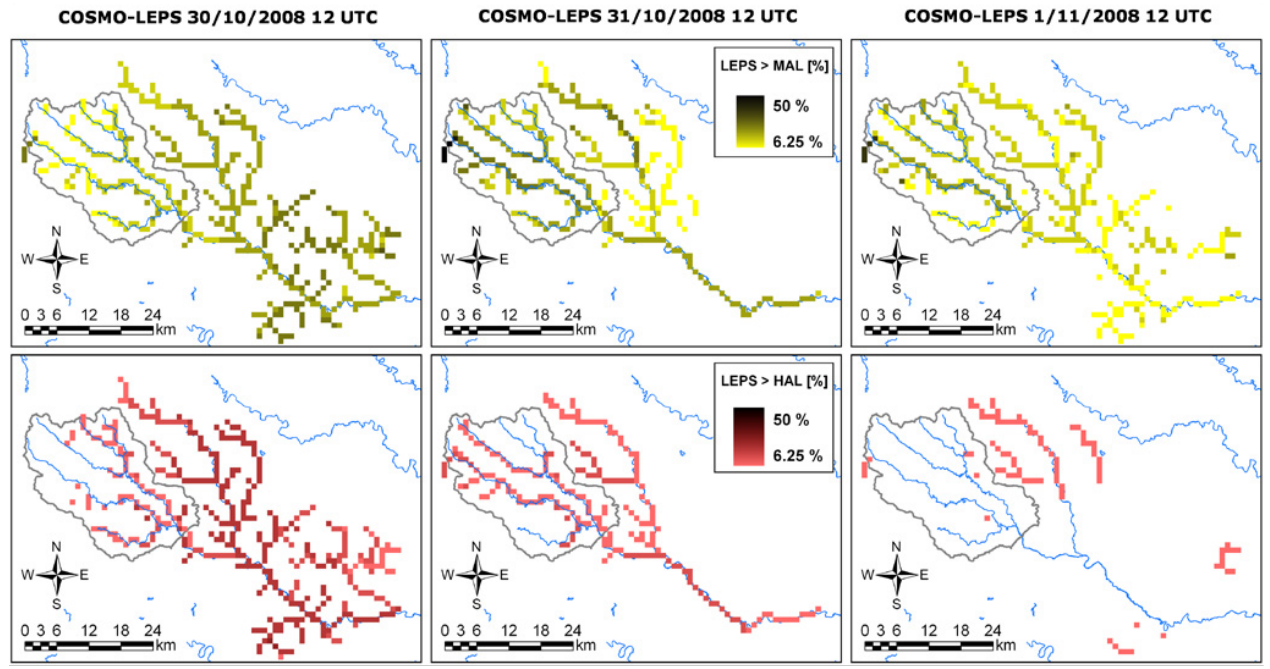
Fig. 2. Probability maps of maximum discharge threshold exceedances for medium (top row) and high (bottom row) alert level in each full forecasting range. Daily COSMO-LEPS forecast at 12:00UTC are shown from 30 October 2008 (left column) to 1 November 2008 (right